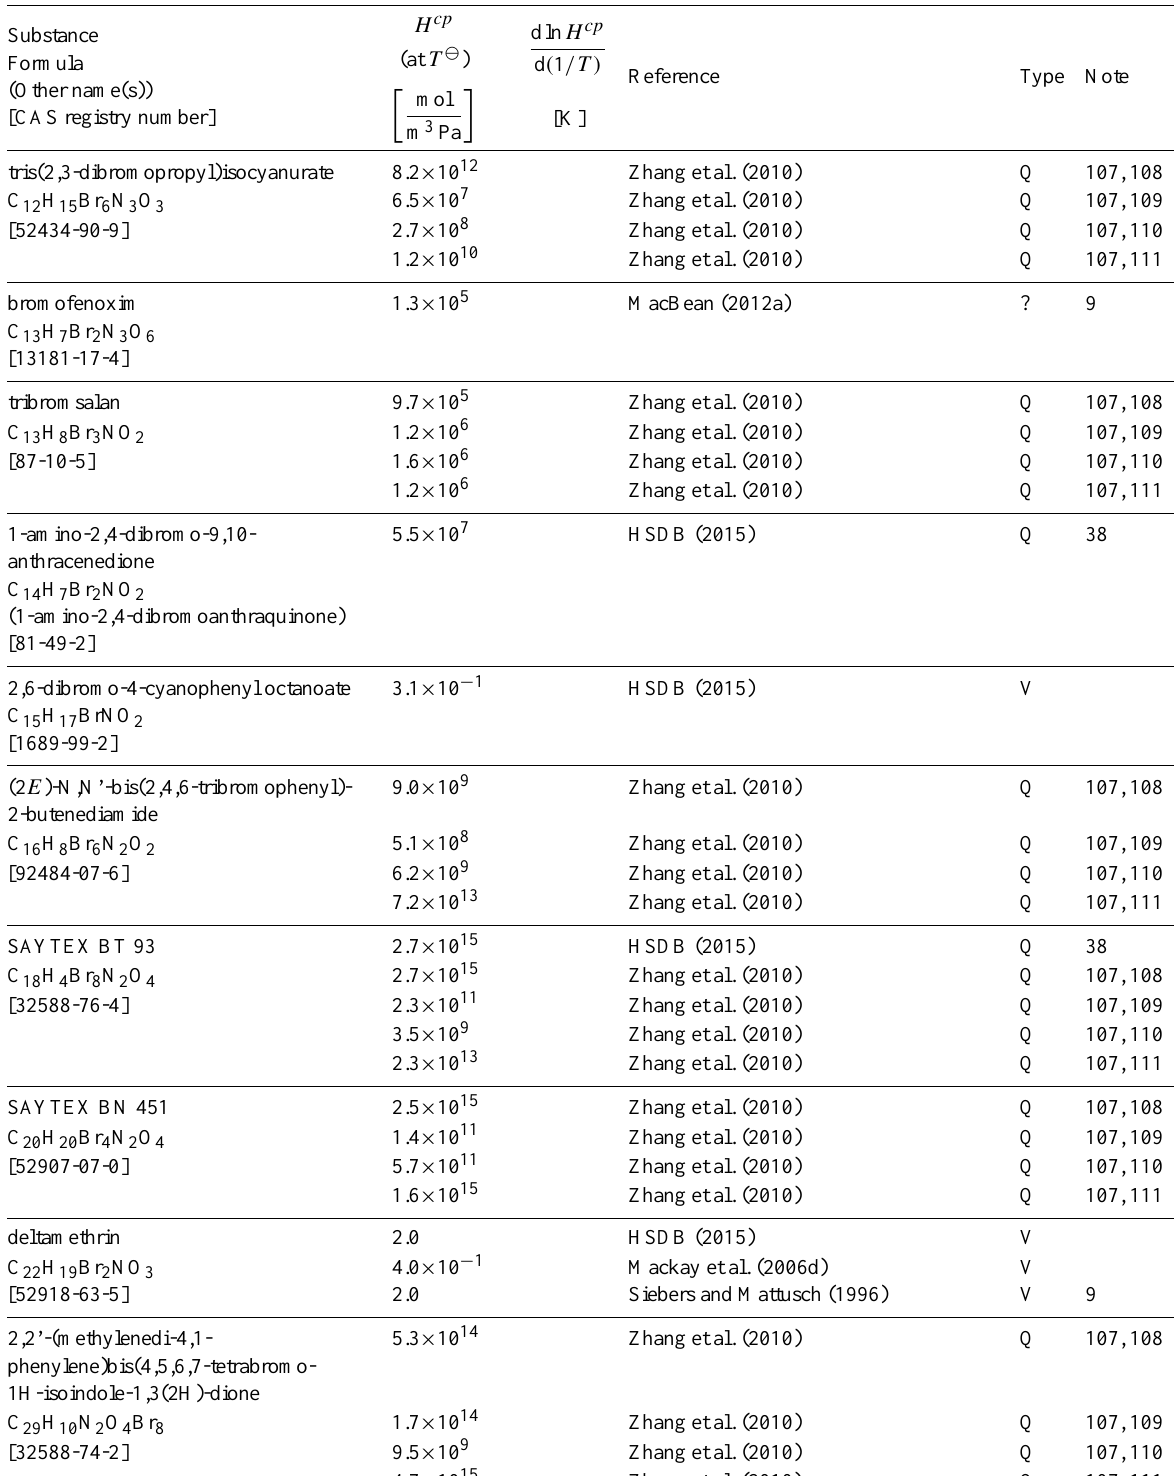
Table 6: Henry’s law constants for water as solvent